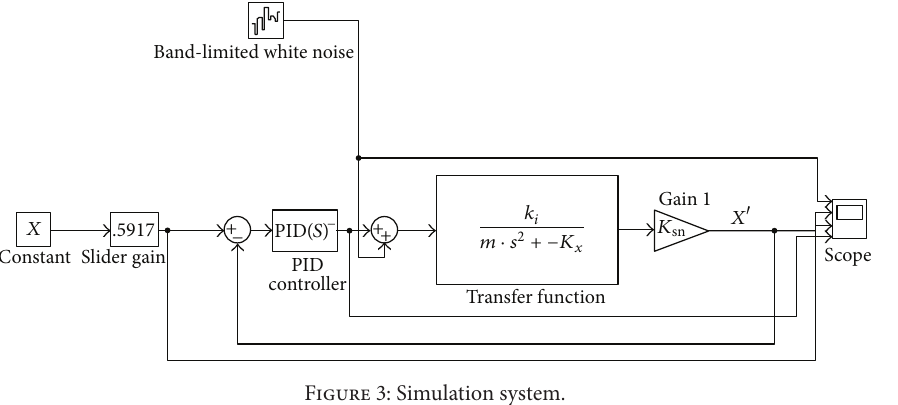
Figure 3: Simulation system.